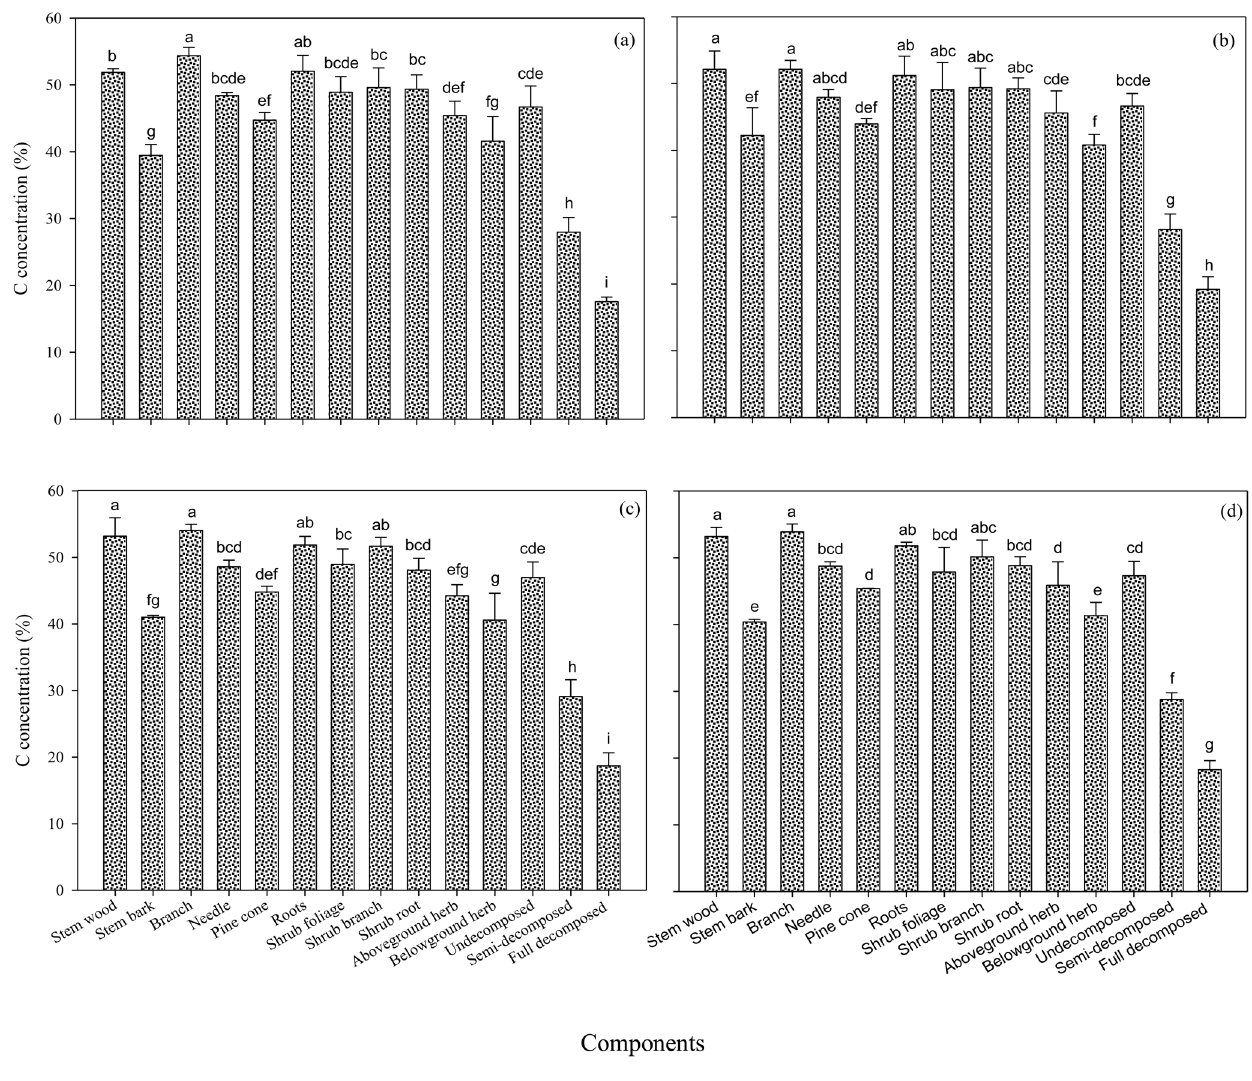
Figure 2. Biomass C concentrations of different components in the young (a), middle-aged (b), immature (c), and mature (d) P. tabulaeformis forests. Different lowercase letters indicate a significant difference within-stand ( p , 0.05).